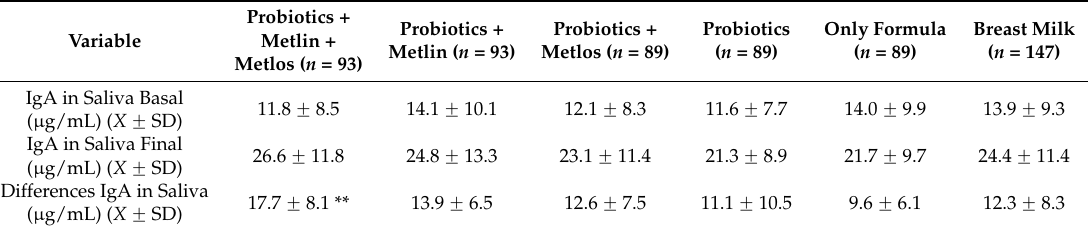
Table 2. Comparative analysis of the saliva immunoglobulin A levels.